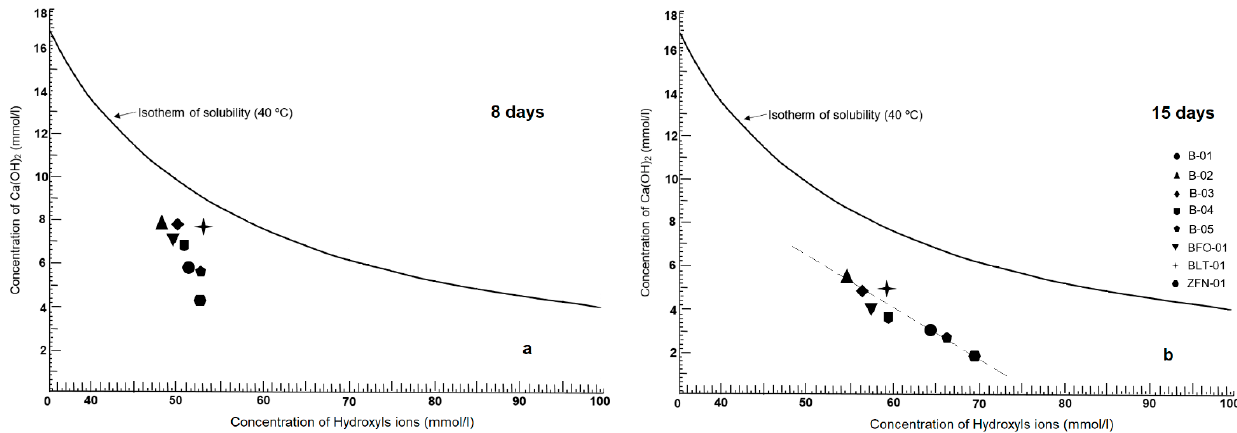
Figure 11. Graphs of Ca(OH) 2 concentration vs. hydroxyl ions (mmol/L) showing the pozzolanic reactivity at 8 and 15 days ( a , b ).